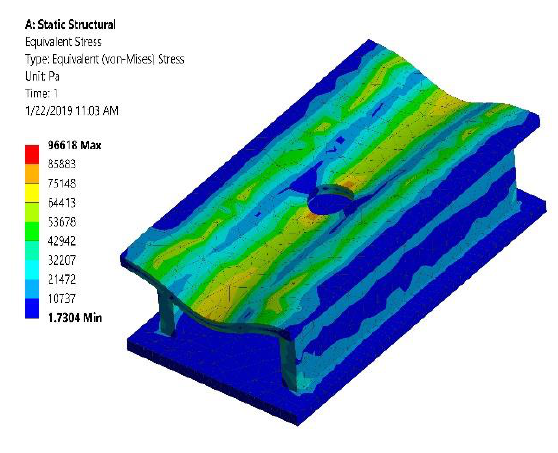
Figure 8. Stress contour of hull